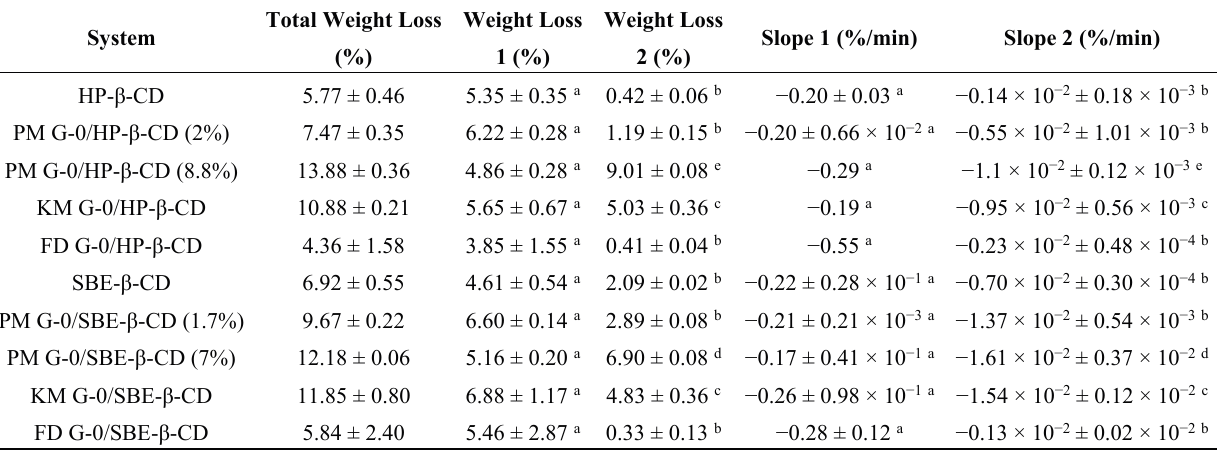
Table 5. Mean and standard deviation of weight loss and sublimation rate (slope) of different cyclodextrin systems with and without G-0, obtained from TGA curves. PM = physical mixture, KM = kneaded mixture, FD = freeze-dried